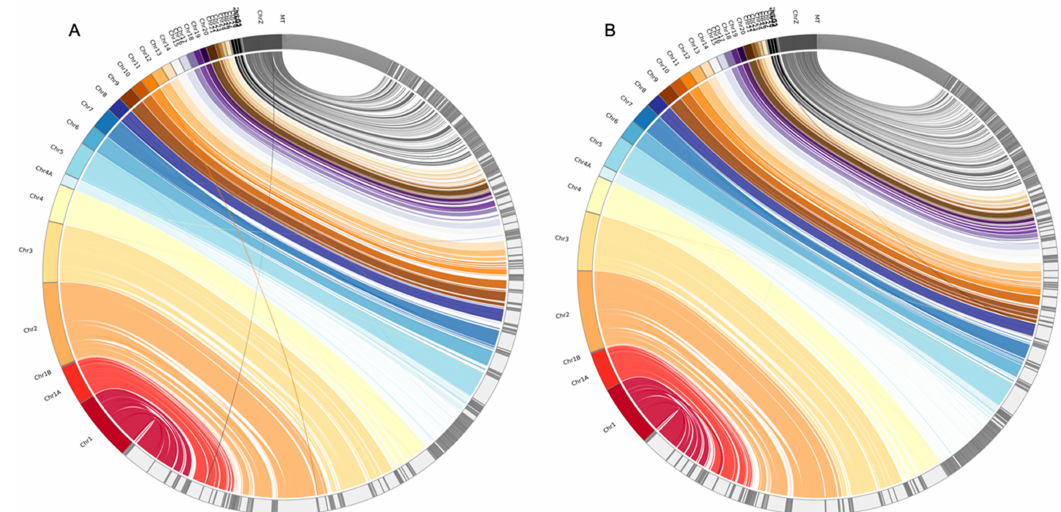
Figure 2. Jupiter plots of the alignments between the rufous-capped babbler and zebra finch genomes. The raw PE ( A ) and trimmed PE ( B ) PLATANUS-assembled genomes are mapped to the zebra finch genome. Only the sca ff olds of the rufous-capped babbler genomes with lengths > 5000 bp were used. The unlocalized sca ff olds of the zebra finch genome were excluded from the